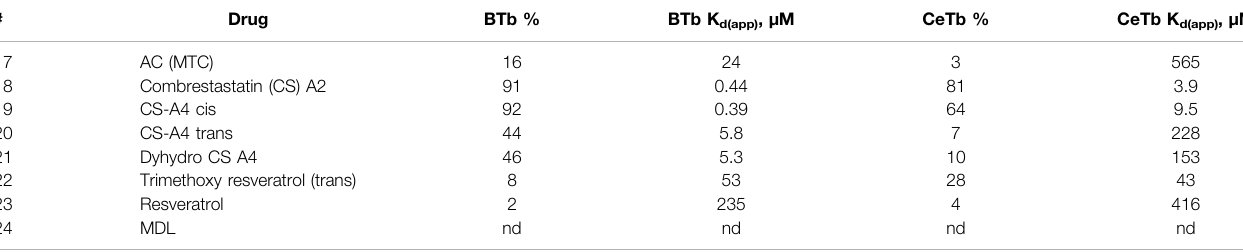
TABLE 6 | MDL competitive binding inhibition by colchicine site 2-ring drugs.